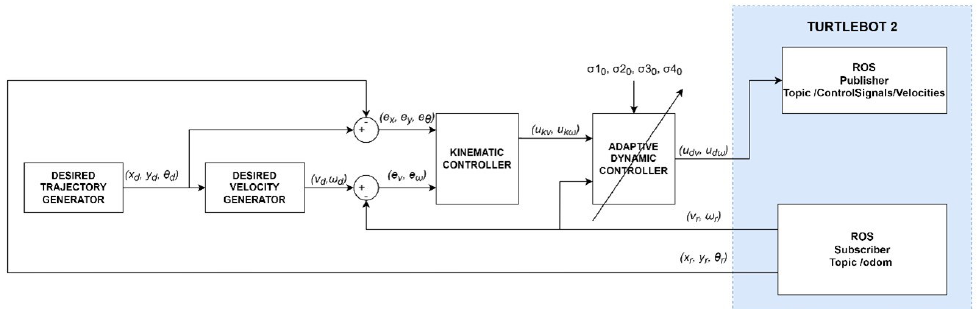
Figure 17. Block diagram of a real robot tracking motion with an adaptive